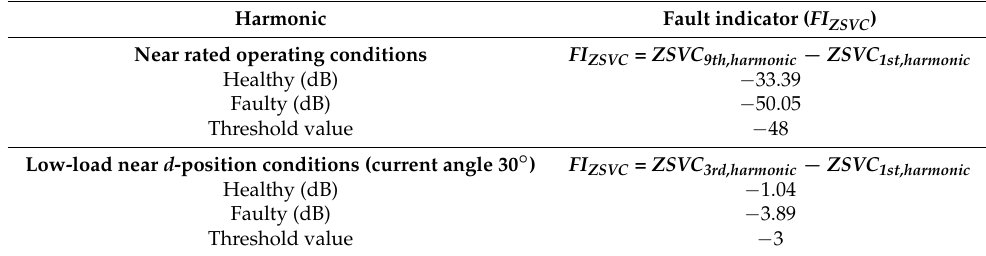
Table 5. Eccentricity fault indicator of the analyzed fPMa-SynRM based on the ZSVC harmonics.